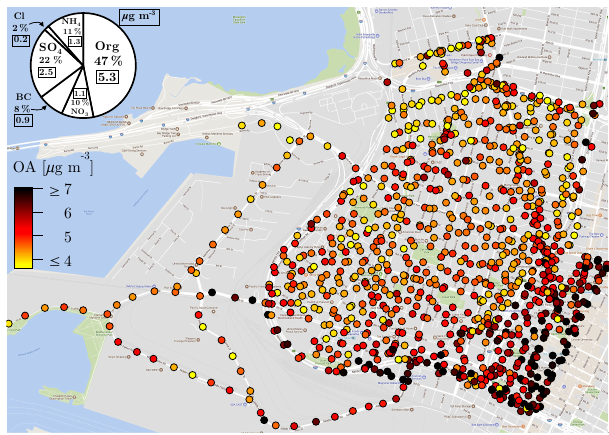
Figure 2. Median organic aerosol concentration at each magnet. The pie chart shows the median contribution of AMS-measured non-refractory (organics: Org, sulfate: SO 2 − , nitrate: NO − , ammo- 4 3 nium: NH + , chloride: Cl − ) and aethalometer-measured black car- 4 bon (BC) to the total PM 1 . Boxed values are absolute mass concen- trations in µgm − 3